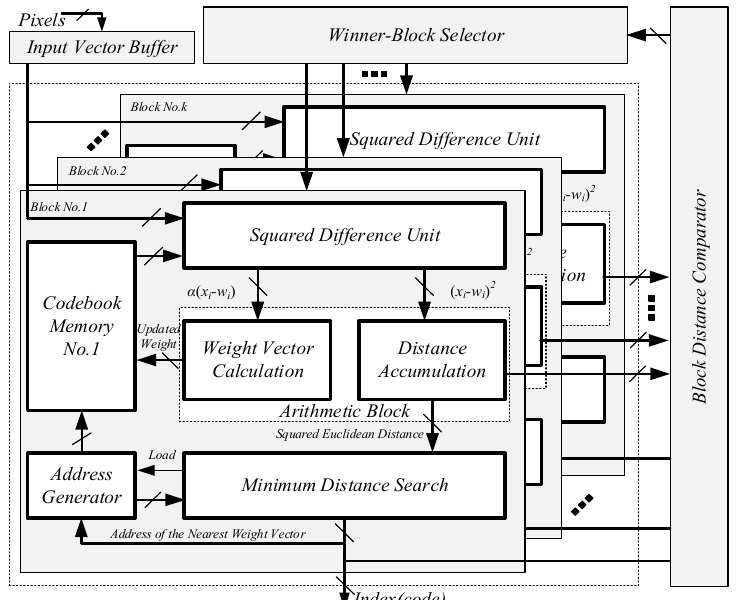
Figure 1. The overall architecture of the proposed vector quantizer.